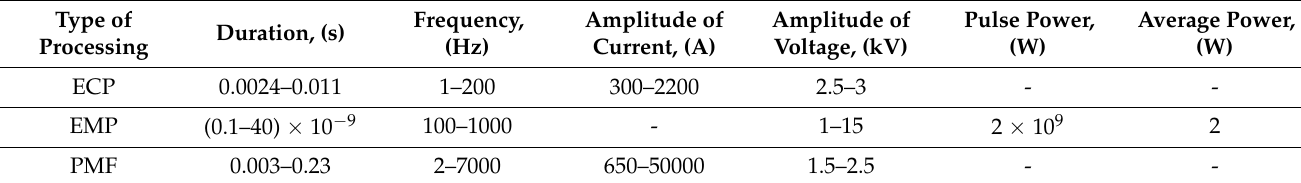
Table 7. Parameters of impulse processing of melts.